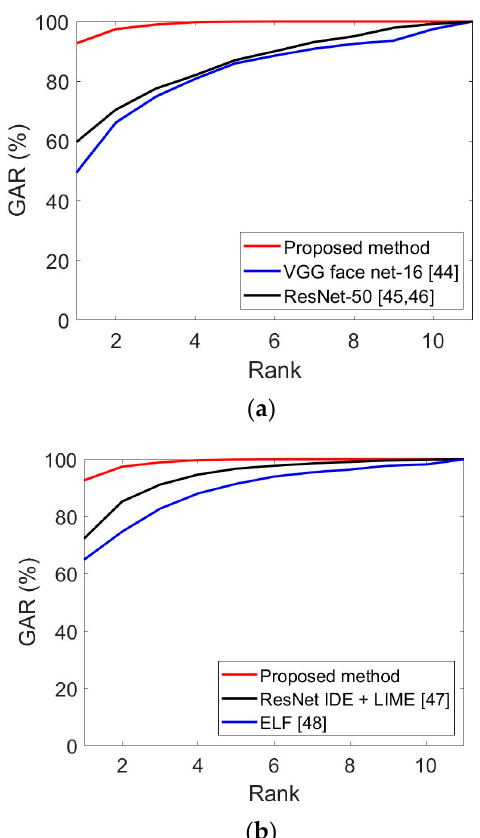
Figure 11. CMC curves of the proposed and state-of-the-art methods. ( a ) Face recognition results